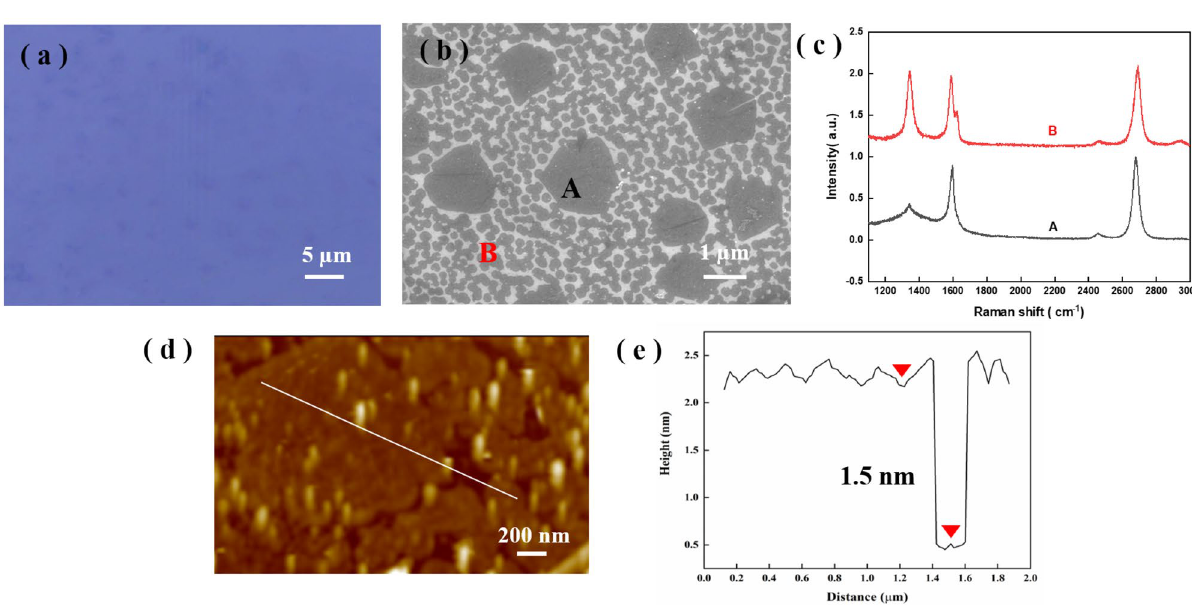
Figure 3. ( a ) Optical microscopy image and ( b ) SEM image of graphene transferred onto SiO 2 /Si. ( c ) Raman spectra at A and B in ( b ). ( d ) AFM image of graphene transferred onto SiO 2 /Si. ( e ) Height diagram of the white line in ( d